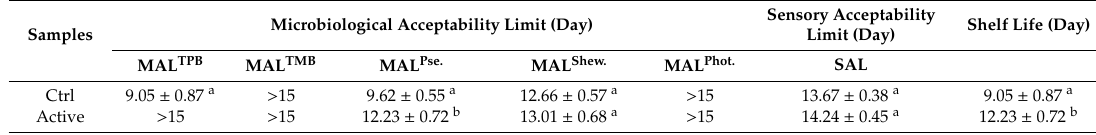
Table 2. Shelf life (day) of breaded cod sticks (Ctrl) and Active breaded cod sticks (Active) as the lowest value among microbiological acceptability limit vales, referred to each spoilage group (MAL for total psychrotrophic and mesophilic bacteria—TPB and TMB, Pseudomonas spp.—Pse., Shewanella —Shew. and Photobacterium —Phot.) and sensory acceptability limit (SAL for overall